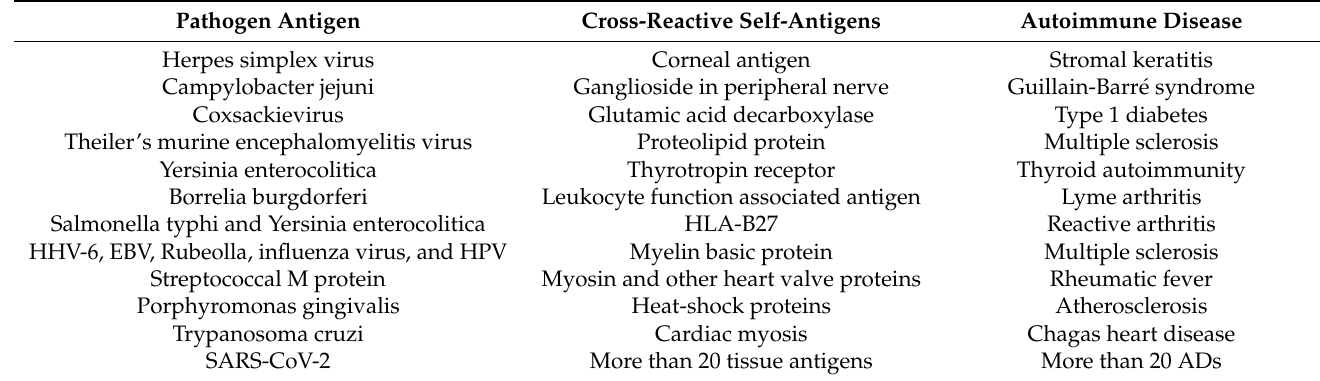
Table 1. Viral and bacterial antigens, their cross-reactive self-antigens, and possibly resulting